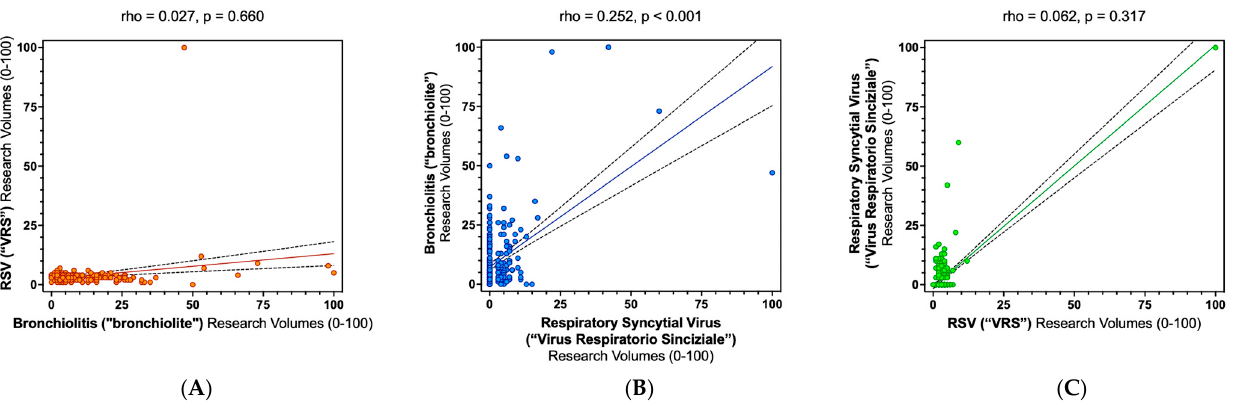
Figure A4 . Correlation between Google Trends TM search terms Bronchiolitis and RSV ( A ), Bronchiolitis and Respiratory Syncytial Virus ( B ), RSV and Respiratory Syncytial Virus ( C ).